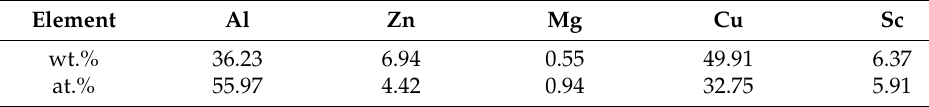
Table 1. EDS analysis results of precipitated phase in